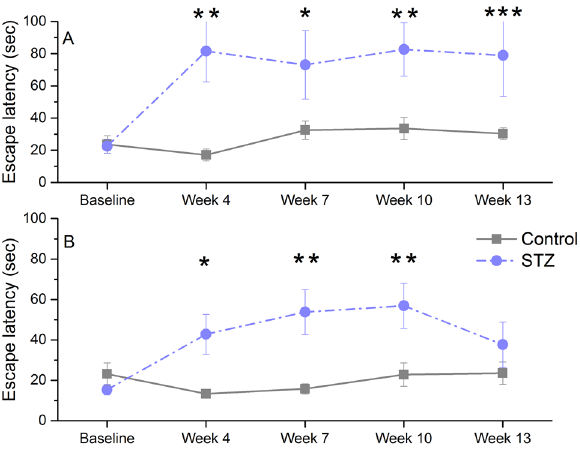
Figure 2. Learning performance of icv. STZ-injected (‘STZ’) and vehicle-treated (‘control’) rats in the Morris water-maze at various time points post-injection. Means ± SEM of daily latency values are shown. ( A ) Results of old rats. *, **, ***: p < 0.05, p < 0.01 p < 0.001: significant difference between groups on days 1 2, 3 and 4 (post-hoc Duncan test following repeated measures ANOVA with significant Day × treatment interaction: F(4, 84) = 6.13, p = 0.000). ( B ) Results of young rats. *, **: p < 0.05, p < 0.01: significant difference between groups on days 1 2 and 3 (post-hoc Duncan test following repeated measures ANOVA with significant Day × treatment interaction: F(4, 88) = 3.88, p = 0.006). Group size of old STZ-treated rats: n = 11 at Week 4 and 6–8, n = 10 at Week 9–11, n = 8 at Week